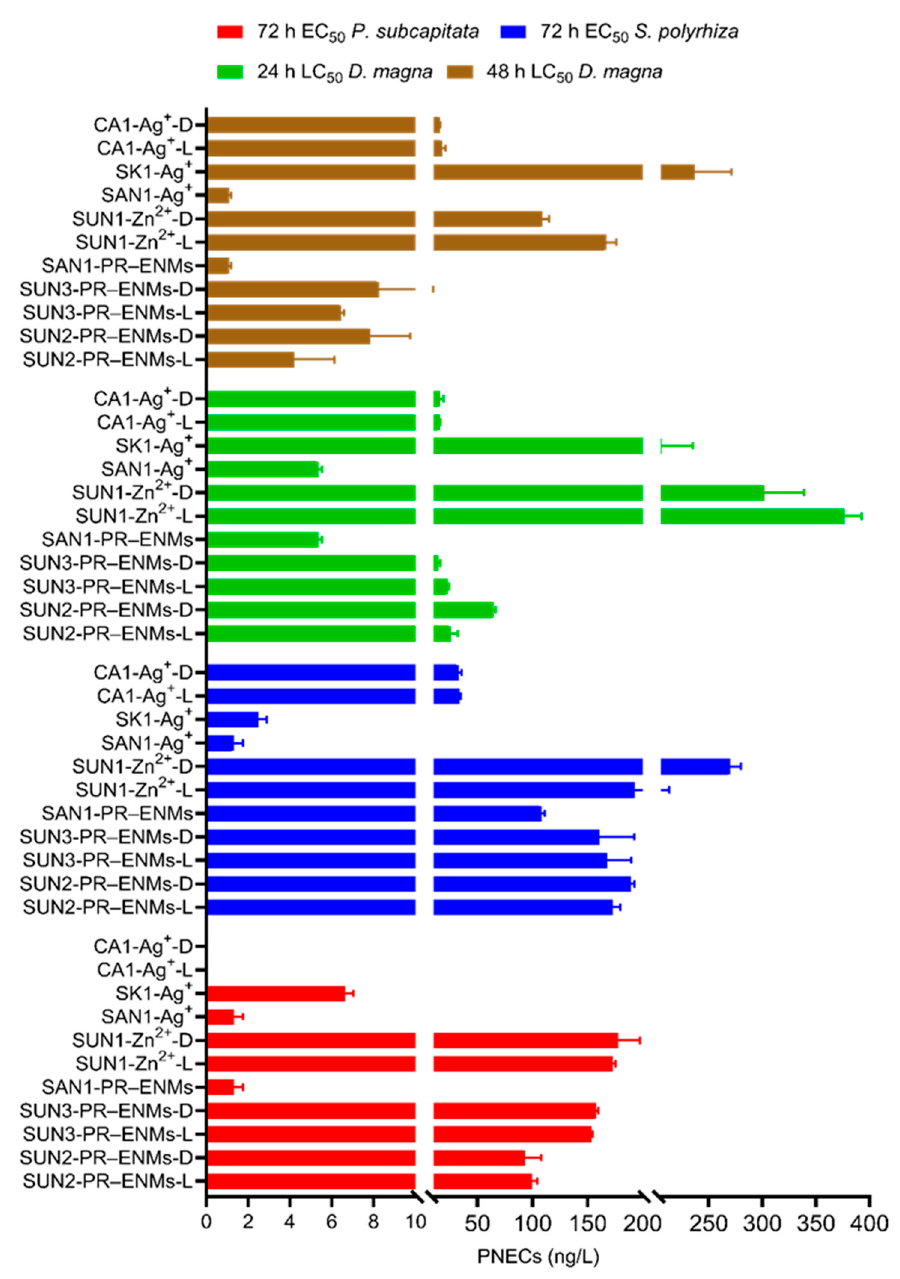
Figure 5. PNECs of PR-ENMs and ions were determined for P. subcapitata , S. polyrhiza , and D. magna . The L and D in the sample names (SUN2, SUN3, ions of SUN1, and CA1) denote PR-ENMs and ions obtained under light and dark conditions, respectively. The PNECs values plotted for SK1 for the test organisms S. polyrhiza , and P. subcapitata are in µg/L and not ng/L .